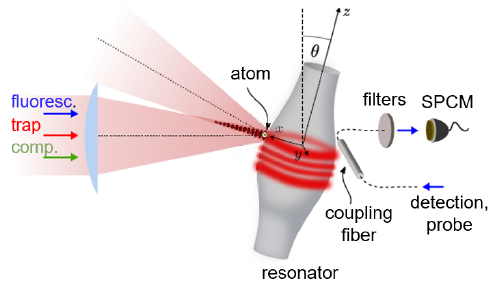
Figure 1. Simplified scheme of the setup for trapping single atoms close to the WGM resonator